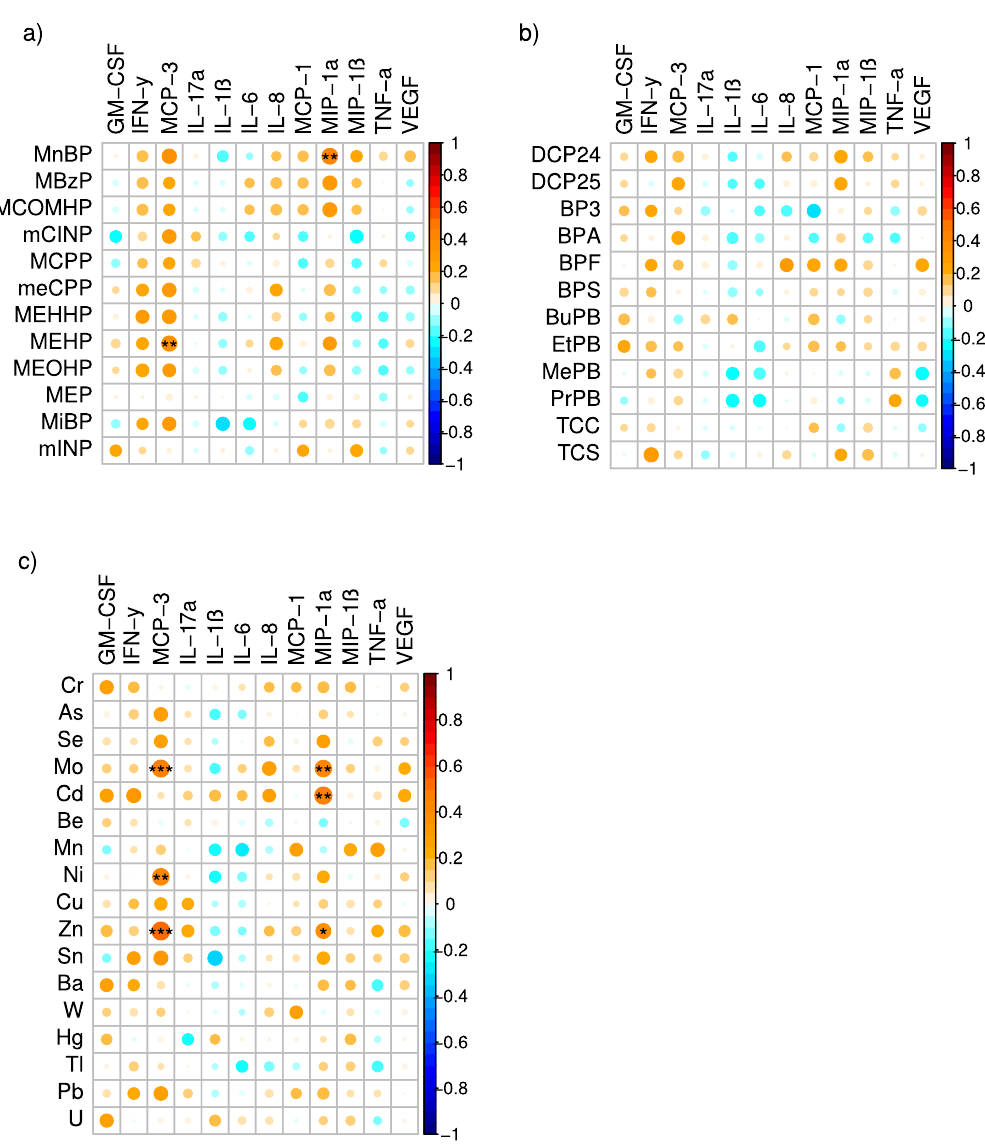
Figure 3. Spearman correlations between early pregnancy EDC exposures and neonatal cord blood inflammatory cytokines. Using the color spectrum, the orange color indicates a positive correlation, while the blue color indicates a negative correlation for cytokines with ( a ) phthalates, ( b ) phenols, and ( c ) metals. Circle size reflects the size of the correlation, with larger circles having correlations closer to 1 or − 1. Shade of